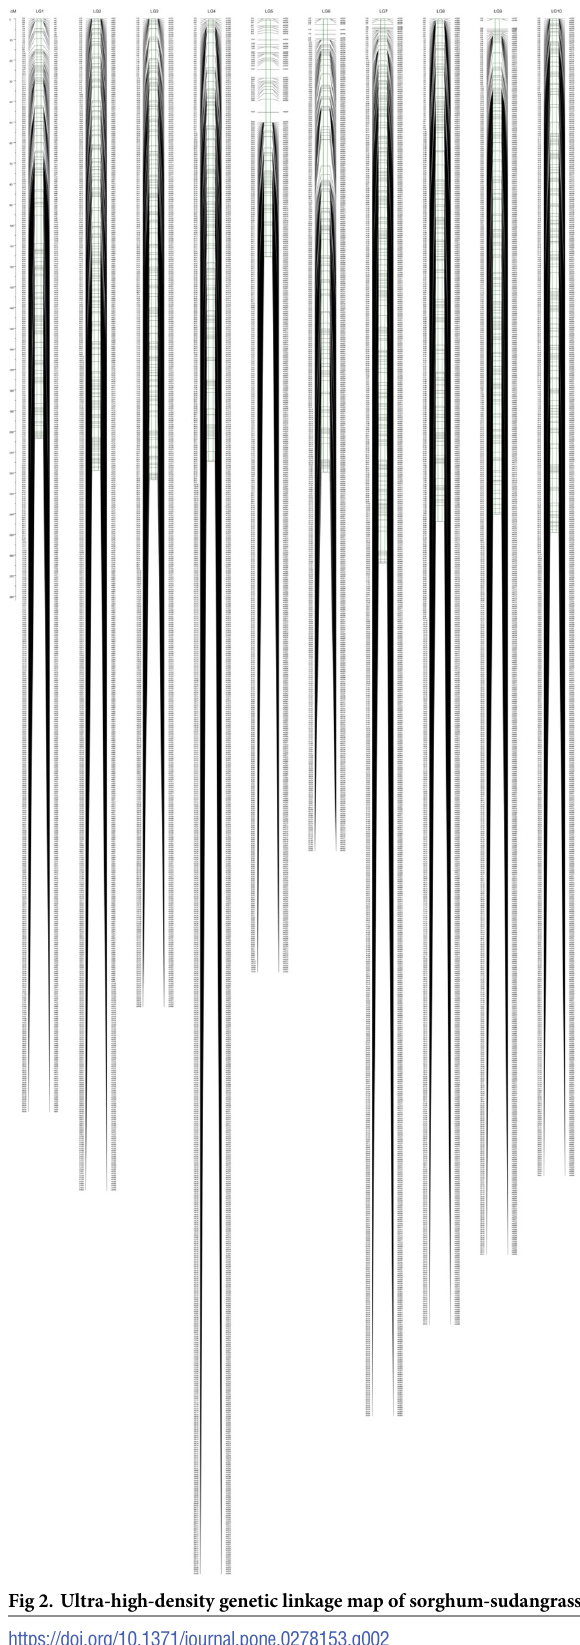
Fig 2. Ultra-high-density genetic linkage map of sorghum-sudangrass hybrid. https://doi.org/10.1371/journal.pone.0278153.g002 PLOS ONE | https://doi.org/10.1371/journal.pone.0278153 November29,